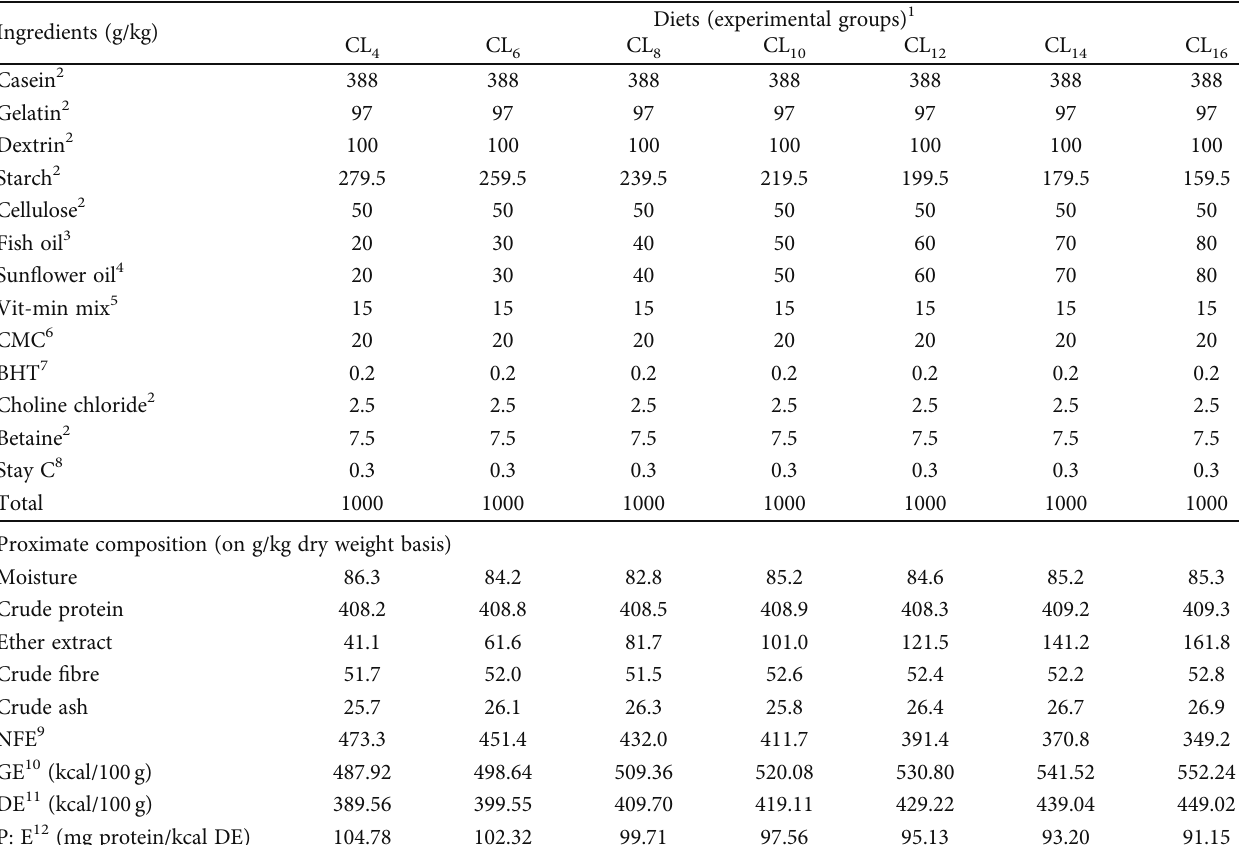
Table 1: Formulation and proximate composition of the experimental diets fed to GIFT juveniles cultured in IGSW of 15 ppt for 60 days. Ingredients